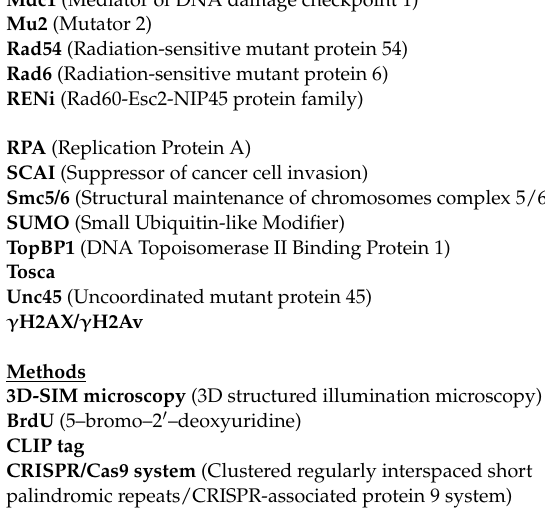
Methods 3D-SIM microscopy (3D structured illumination microscopy) Super resolution microscopy technique. BrdU (5–bromo–2 (cid:48) –deoxyuridine) Nucleotide analog. CLIP tag